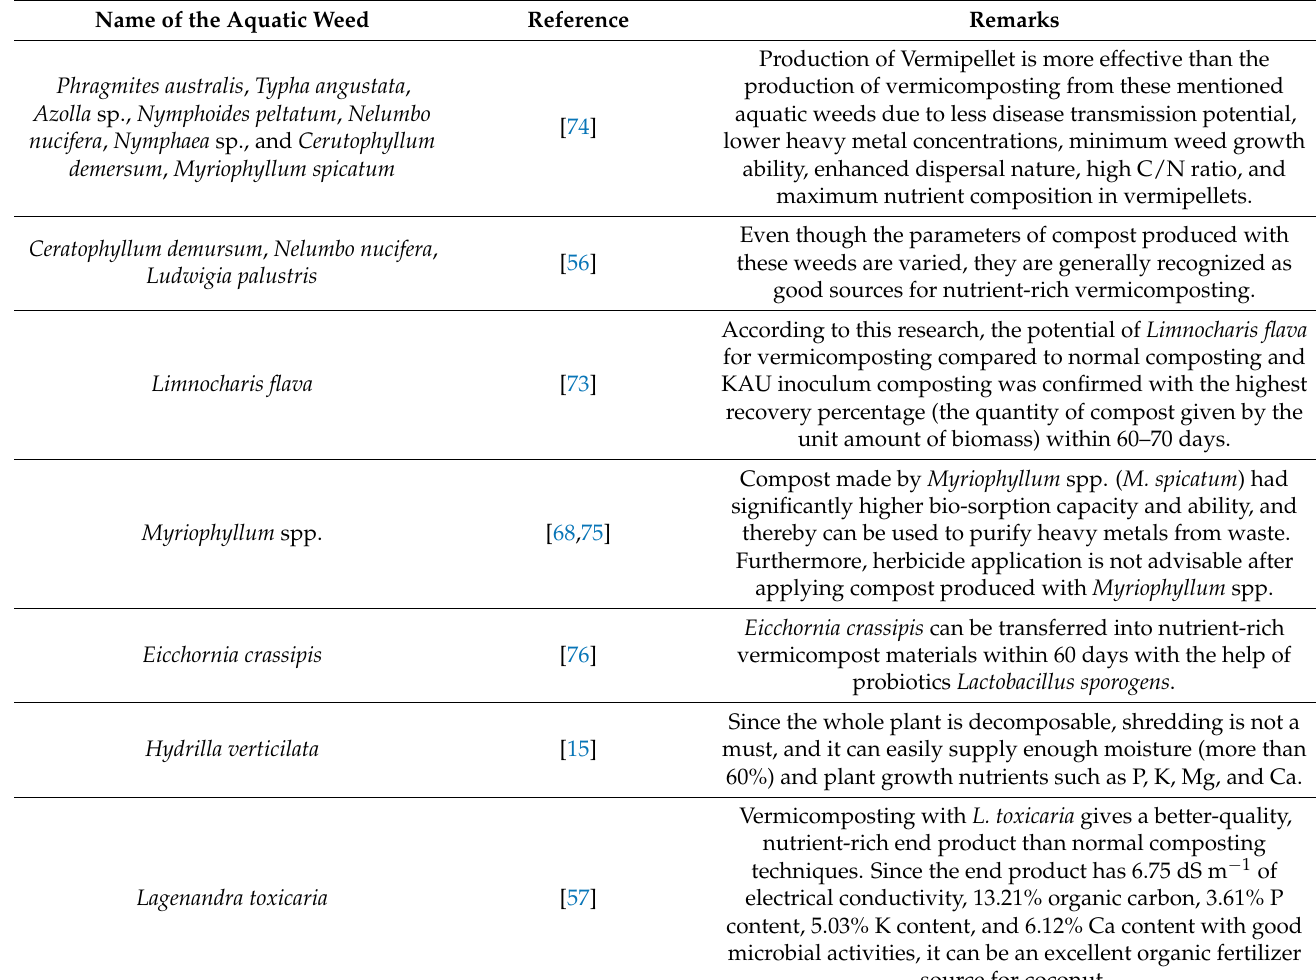
Table 6. Experiments on composting with aquatic